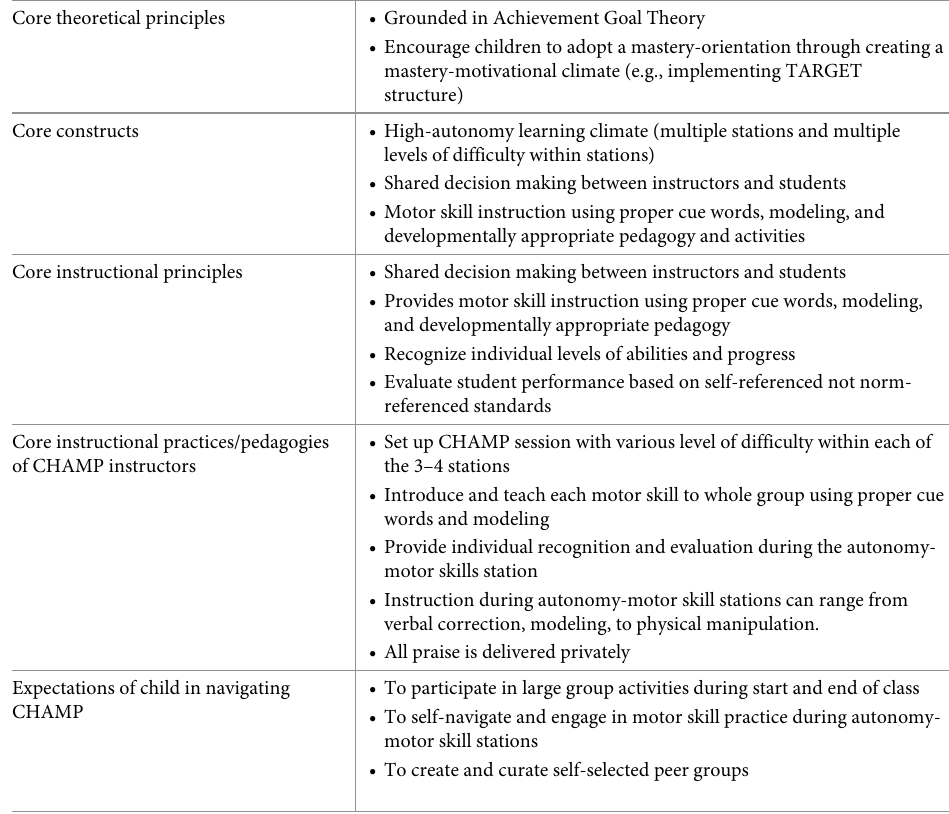
Table 2. Core tenants of